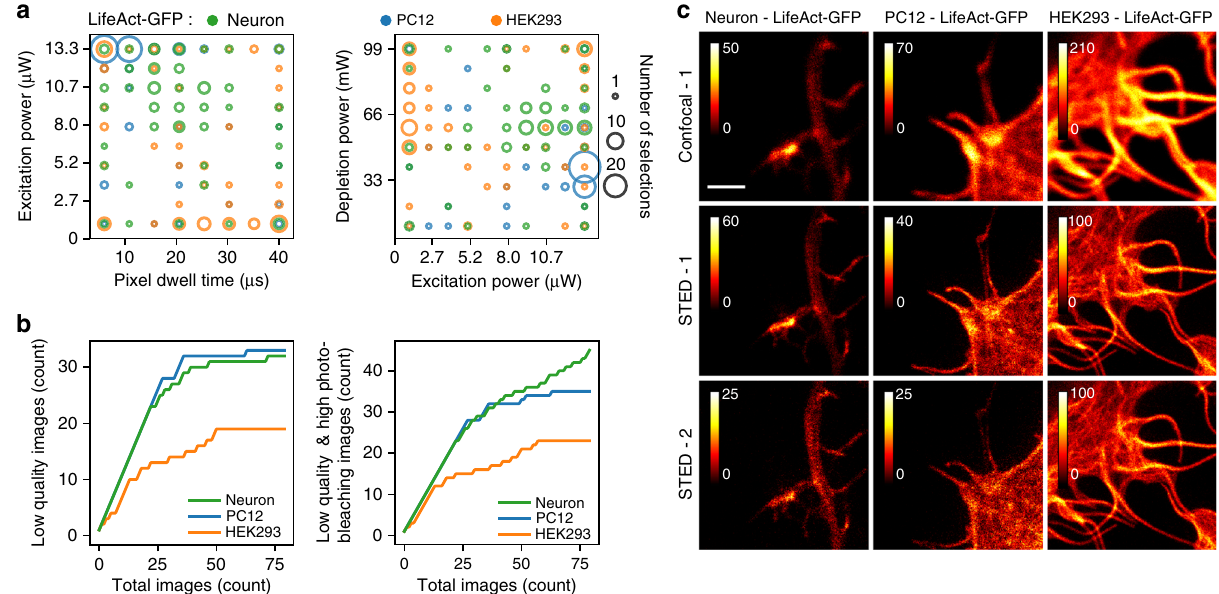
Fig. 3 Multi-objective live-cell optimization of GFP imaging. a Parameter con fi gurations selected by Kernel TS during different imaging trials in three different cell types: neurons (green), PC12 (blue), and HEK293 (orange). b Cumulative regret curve of (left) image quality alone (images with a quality score below 60%) and (right) image quality and photobleaching (images with a quality score below 60% or photobleaching above 75%). c Example images obtained among the last ten images of one optimization sequence for each cell type. The confocal image was taken before two consecutive STED images (labeled as STED-1 and STED-2). Note the differences in intensity scales across images to re fl ect differences in fl uorescence intensity (confocal images) or photobleaching (STED1 vs. STED2). Scale bar 1 μ